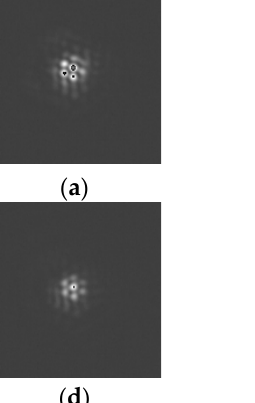
1. The images correspond to a tracking time, t, of ( a ) 180 s, ( b ) 420 s, ( c ) 540 s, ( d ) 780 s, ( e ) 900 s, and